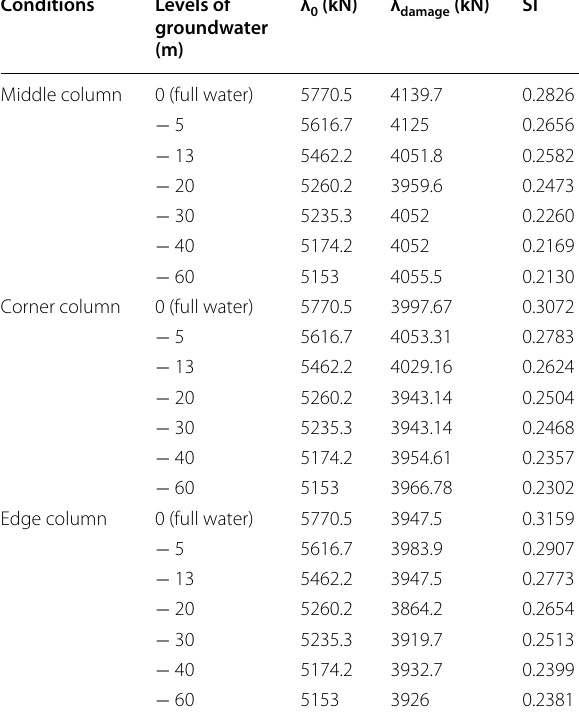
Table 13 Redistribution of the imposed loads in the 20-story RC framed structures with different levels of groundwater in the substructure soil/